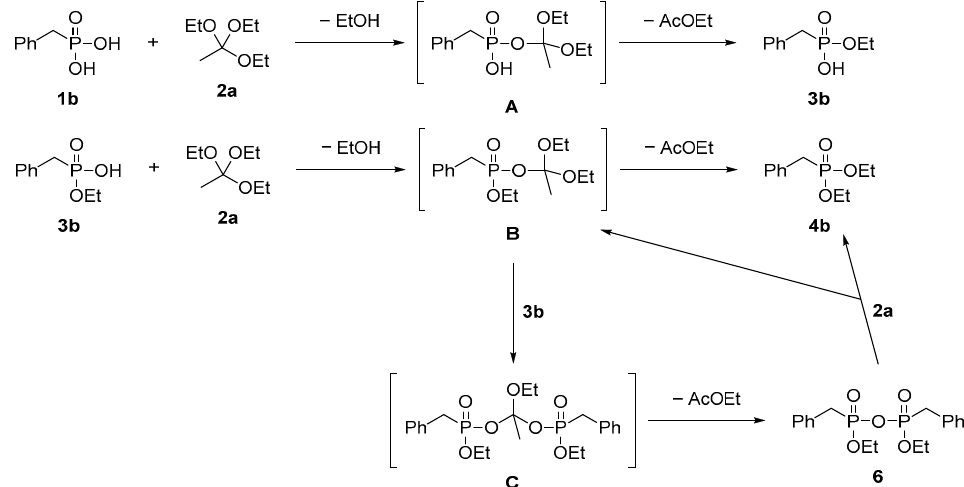
Figure 4. Changes in concentration of products with time. The analysis of obtained data provided some insight into the reaction mechanism (Scheme 2). The first step is the reaction between triethyl orthoacetate ( 2a ) and benzylphosphonic acid ( 1b ) which leads to the formation of an unstable intermediate A . It readily decomposes to monoester 3b by releasing one molecule of ethanol and ethyl acetate in a two-step process, at room temperature. The intermediate A can be formed only from selected substrates used as alkoxy group donors, depicted in Figure 1. This mechanism allowed us to explain why only monophosphonates were formed from orthoesters 2a and 2b , diethoxymethyl acetate 2g and tetramethyl orthocarbonate 2h . At higher temperatures, monoester 3b reacts with a second molecule of triethyl orthoacetate to give intermediate B , similar to A . This intermediate can react with the second molecule of monoester 3b to give compound C which is readily transformed into pyrophosphonate 6 and its structure was ambiguously assigned by kinetic experiments. Compound 6 reacts with the third molecule of orthoester 2a to give the final product diester 4b and intermediate B . According to this mechanism, for the formation of one molecule of diester 4 , three molecules of orthoester 2a are required. This readily explains why the larger amount of triethyl orthoacetate favors double esterification with respect to monoesterification.